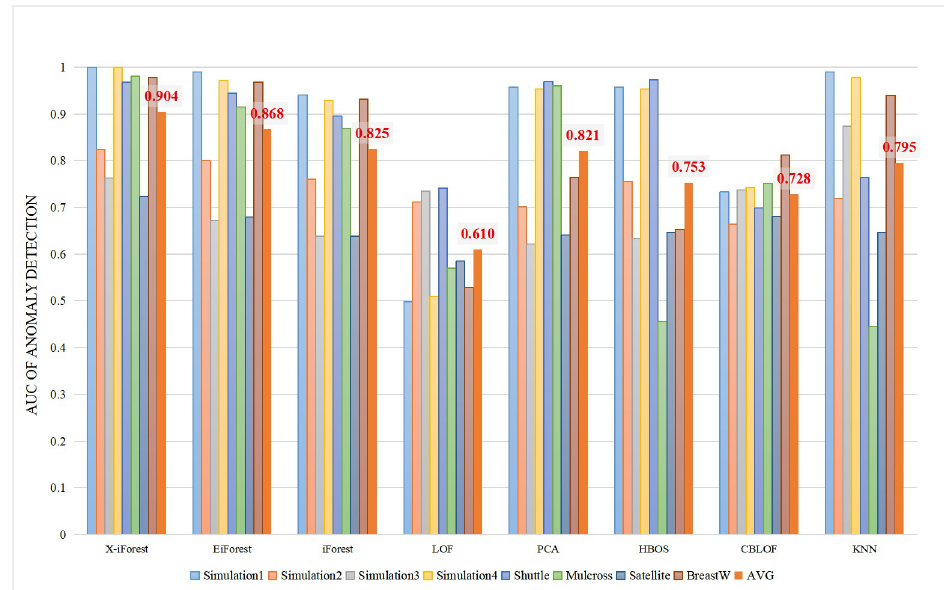
and far better than those of the other algorithms. The results from the AUC experiments show mental results show that EiForest did not achieve high ADR values in the Simulation2 and Sat- ellite Dataset. The average ADR of X-iForest is 19.5% higher than that of iForest and 10.1% of EiForest, which means that X-iForest can better complete the anomaly detection task. Based on the results, X-iForest has the best performance in both simulation datasets and the real datasets, maintaining high AUC and ADR performance, which shows that X-iForest can complete anomaly detection tasks well while maintaining high accuracy. The AUC of X-